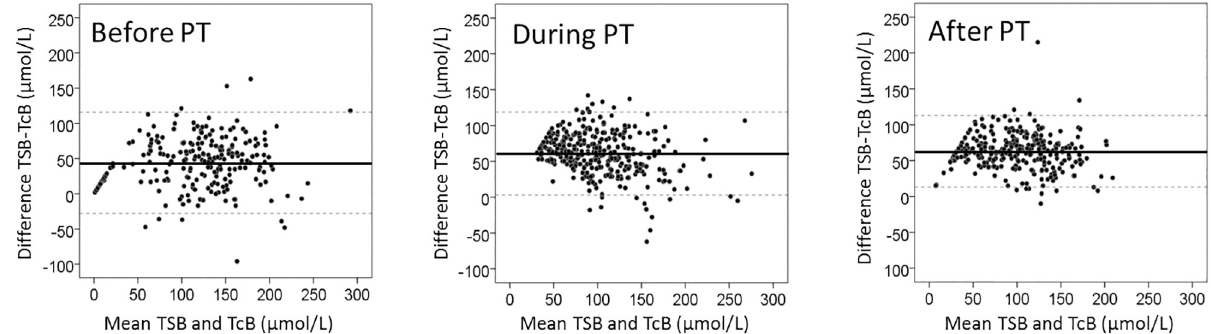
Fig 2. Bland Altman plots before, during, and after phototherapy. The agreement between TSB and TcB before, during, and after PT. The x–axis shows the mean of TSB and TcB ( μ mol/L) and the y–axis shows the difference between TSB and TcB ( μ mol/L). The horizontal line represents the mean difference; the dotted lines represent the 95% confidence interval. 17.1 μ mol/L = 1 mg/dL bilirubin.